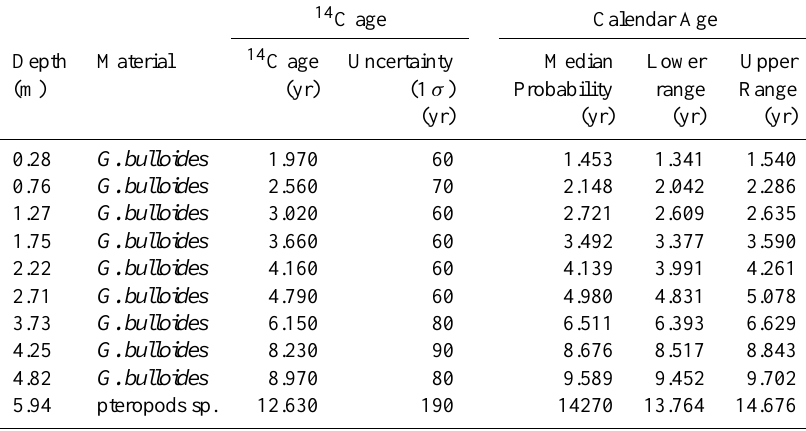
Table 1. 14 C-AMS dating of core MD77-191 (for Site ODP 723, see Gupta et al.,